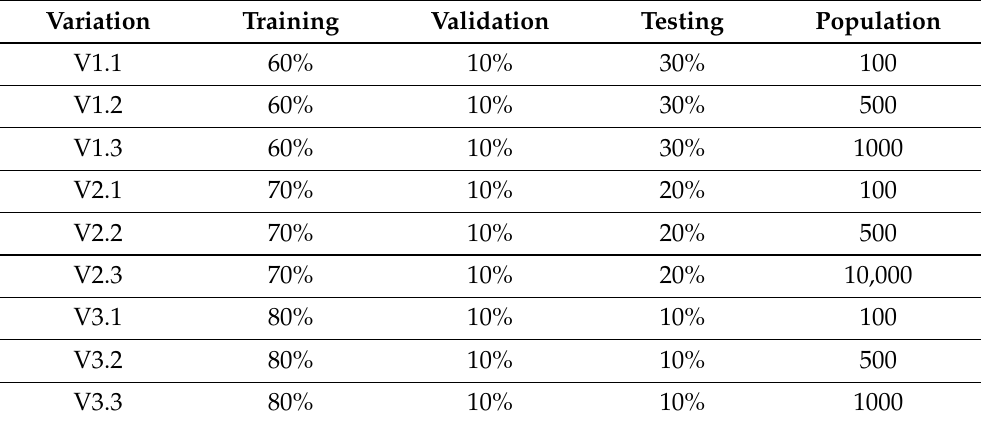
Table 4. Variations in the developed